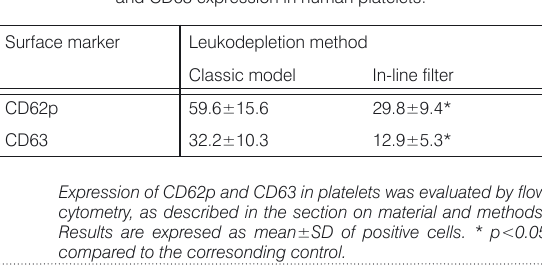
Table 1 Volume and number of blood cells of final filtered components compared to nonfiltered units.